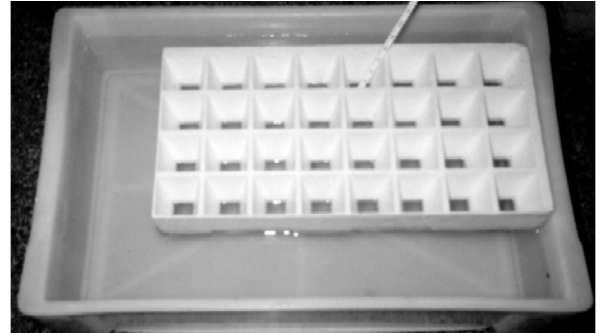
Figura 1. Sistema de sustentação utilizado para o “screening” de plantas de Panicum maximum em solução nutritiva. O fundo da bandeja de isopor foi forrado com tela de